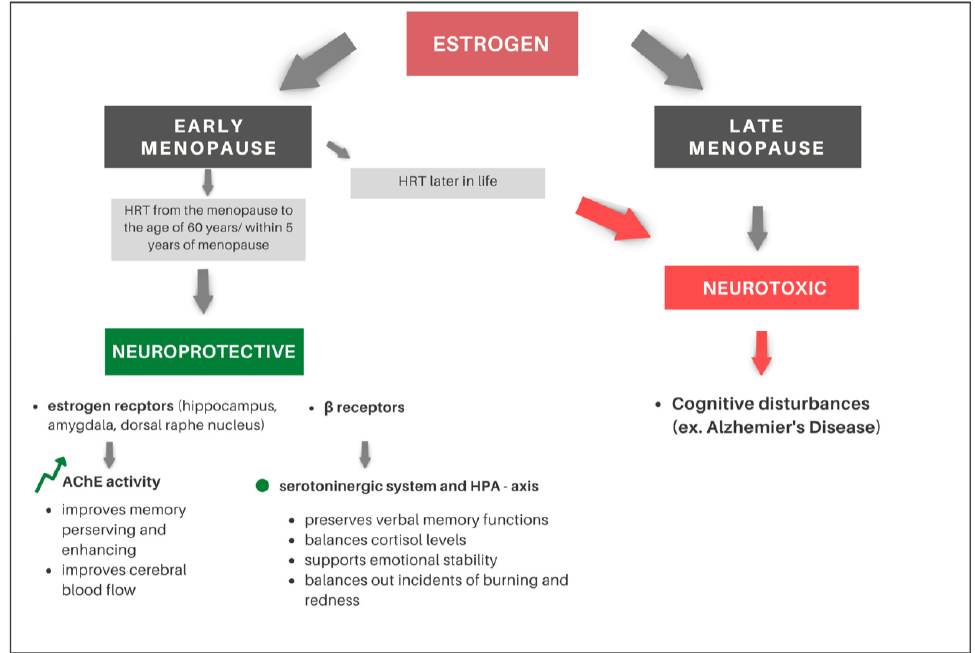
Figure 4. The impact of estrogen therapy in early menopause and prolonged reproductive period on cognitive impairment. At the present stage of knowledge about the pathomechanism of cognitive decline in postmenopausal women, it can be assumed that estrogen can play neuroprotective or neurotoxic role sin early menopause and late menopause, respectively. Women who experience menopause later in life have higher estrogen levels when they are more advanced in age and that is the time when dementia-related pathologies accumulate. Therefore, higher estrogen levels may become neurotoxic in older age, which explains why HRT turns out to be beneficial in terms of dementia risk if administrated within 5 years of the menopause but has negative effects if administrated after that time.